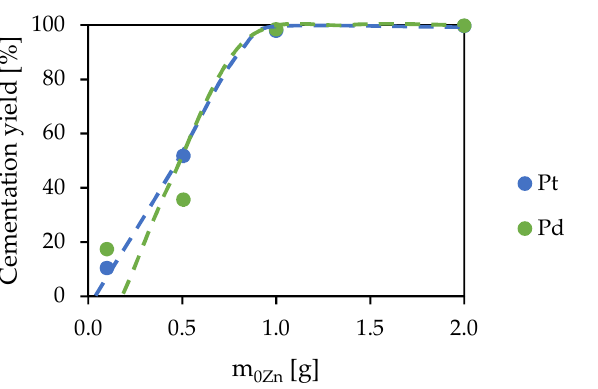
Table 7. Cementation experiment results with the use of zinc powder; m 0Zn —initial mass of zinc powder, m fZn —final mass of zinc powder.